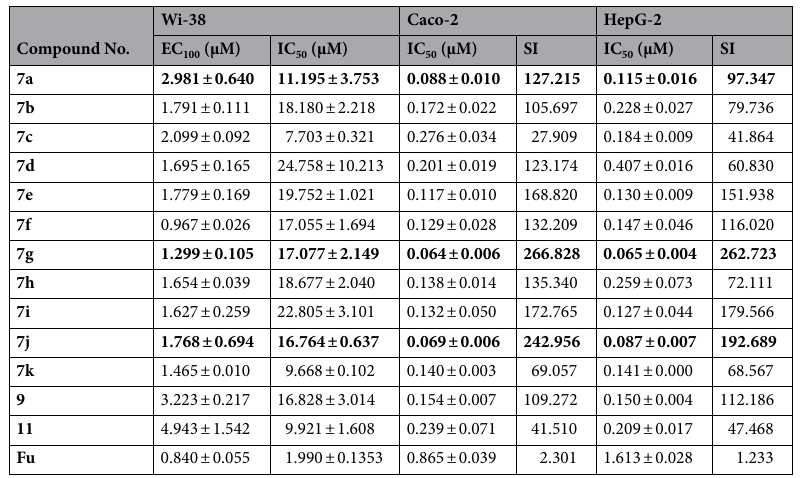
Table 1. In vitro cytotoxicity profiles of the Passerini adducts against Wi-38, Caco-2 and HepG-2 cells in terms of IC 50 as detected by MTT assay and their selectivity index (SI) values. Significant values are in bold. *Values are expressed as mean ± SEM. SI is the ratio between the compound’s IC 50 against normal cells and its IC 50 against cancer cells. SI ≥ 3 refers to selective compound [30]. 5-FU stands for